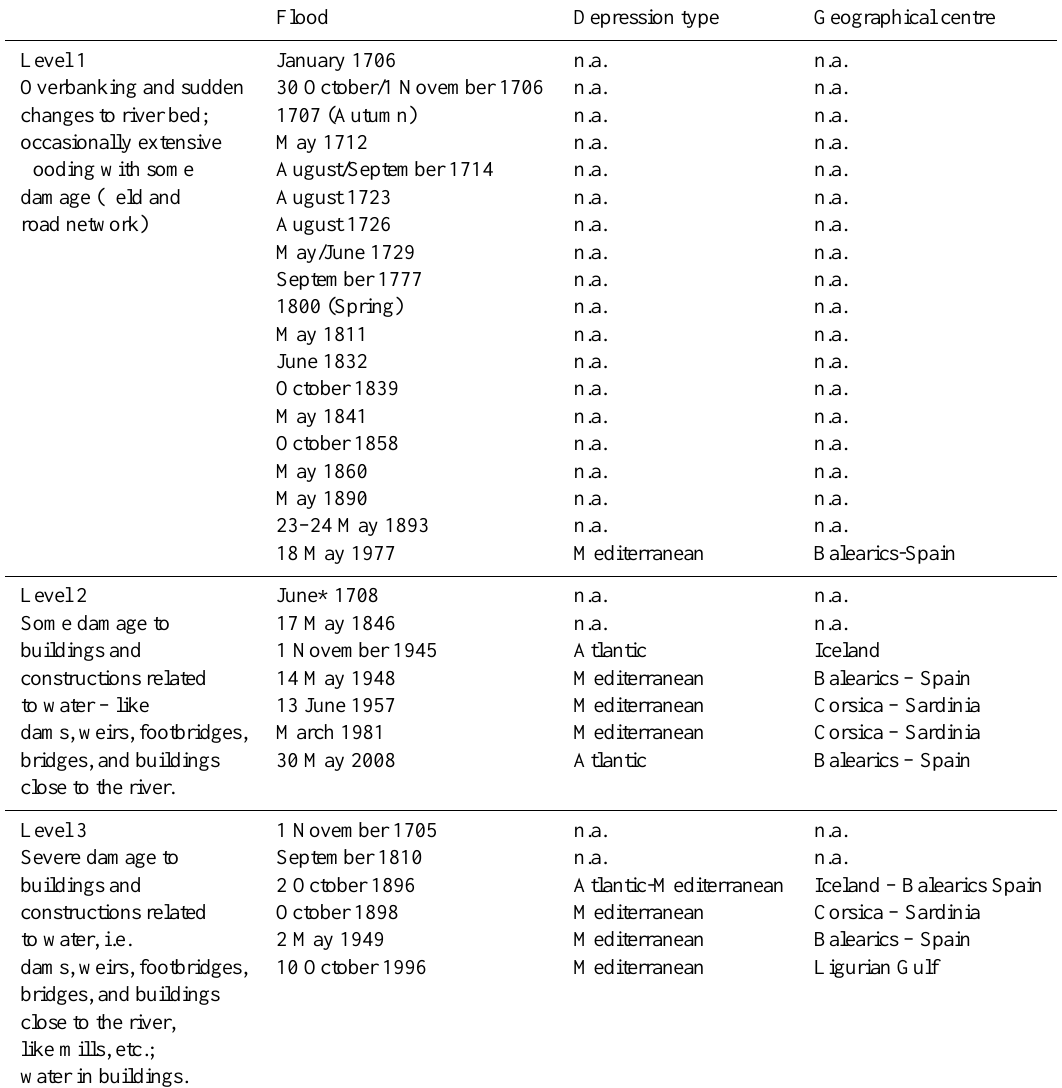
Table 1. Savigliano: main historical floods since 1700, and different critical levels (by Govi and Turitto, 1994, modified). In level 1 the floods without exact month are not indicated. Meterological configurations and generating depression system are indicated (data derived by Nigrelli and Audisio, 2009 and http://www.wetterzentrale.de, access: 15 February 2010 and 6 July 2011; n.a. indicates not available